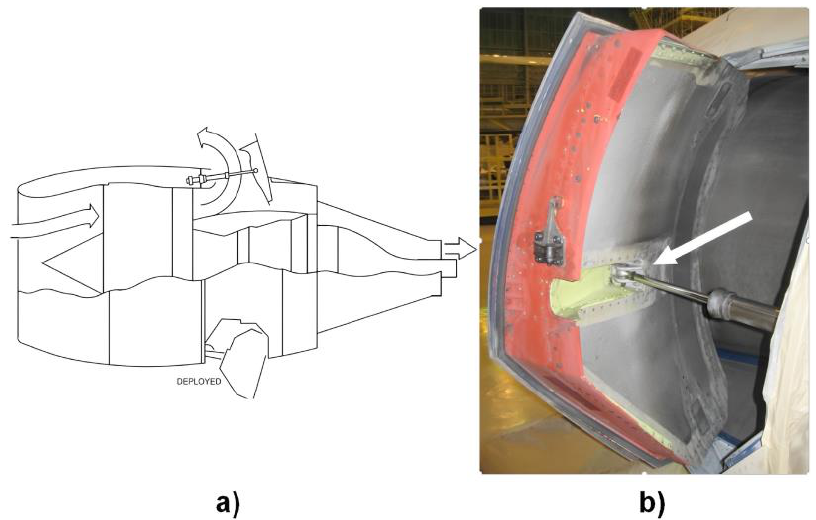
Figure 7. ( a ) Pivoting door operation, ( b ) pivoting door detail.